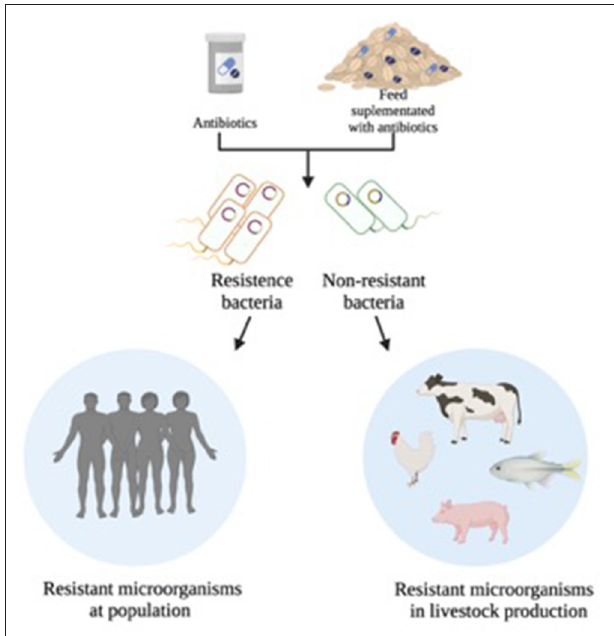
FIGURE 1 | Representation of antibiotic-resistant bacteria in different ecosystems: antimicrobial usage may select the genes encoding resistance. Drug-resistant bacteria can spread when domestic animals receive antibiotics and develop antibiotic-resistant bacteria in their gastrointestinal tracts (GIT). This contamination can occur through humans, among vulnerable patients in hospitals or with contact with contaminated surfaces. These bacteria can be propagated in humans either through the food supply chain (meat and dairy products) or by direct animal contact. In addition, they can spread via water containing animal feces used for animal crops, or drug-resistant bacteria can remain on crops and be eaten. In this way, bacteria can remain in human and animal guts and spread in the